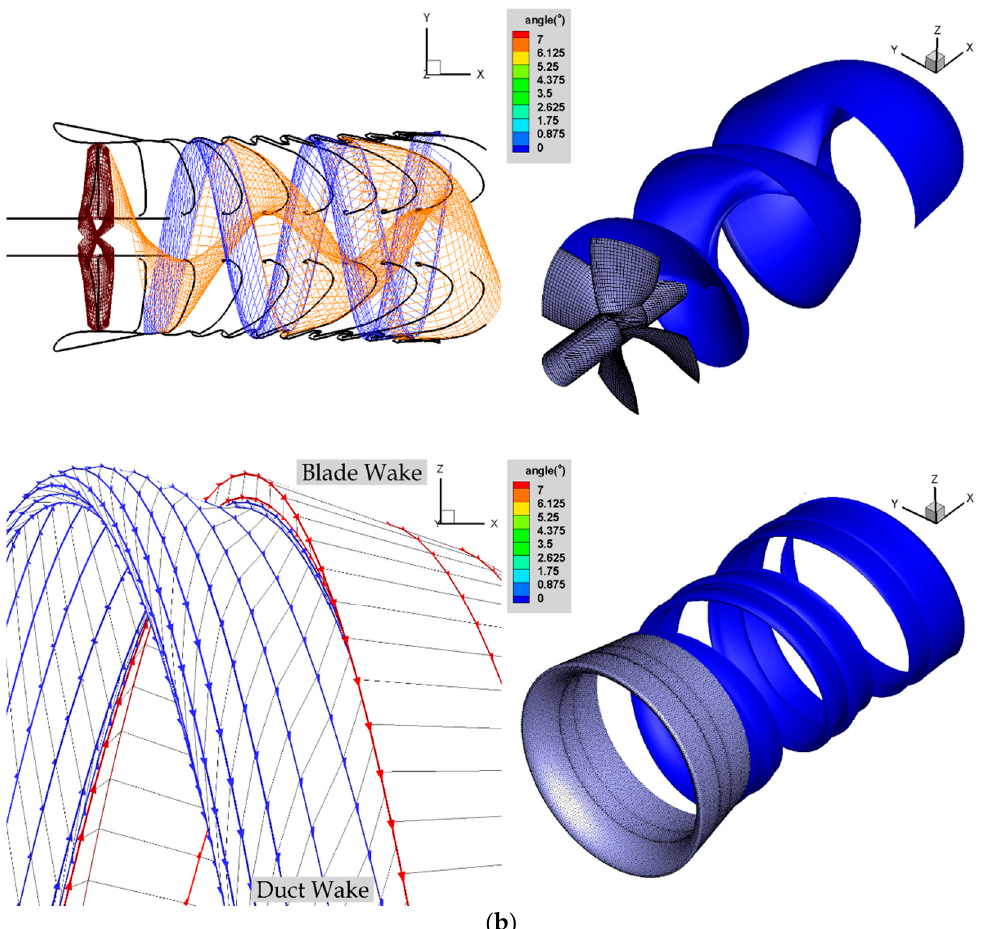
Figure 10. Blade and duct wake shapes at the first iteration ( a ), and converged last iteration, after full wake alignment on both blade and duct wakes ( b ). Shown are the blade and duct wake shapes, as intersected by a vertical plane through the propeller axis ( top left ), the total velocity vectors together with the streamwise vortex segments ( bottom left ), and contour plots of the angle of the total velocity vectors with the trailing vortex segments on the blade wakes ( top right ) and duct wakes ( bottom right ). The transverse vortex segments of zero strength are shown too. The total velocity vectors should be tangent to the streamwise vortex segments for force-free wake, as this can be verified by the contour plots in ( b ).